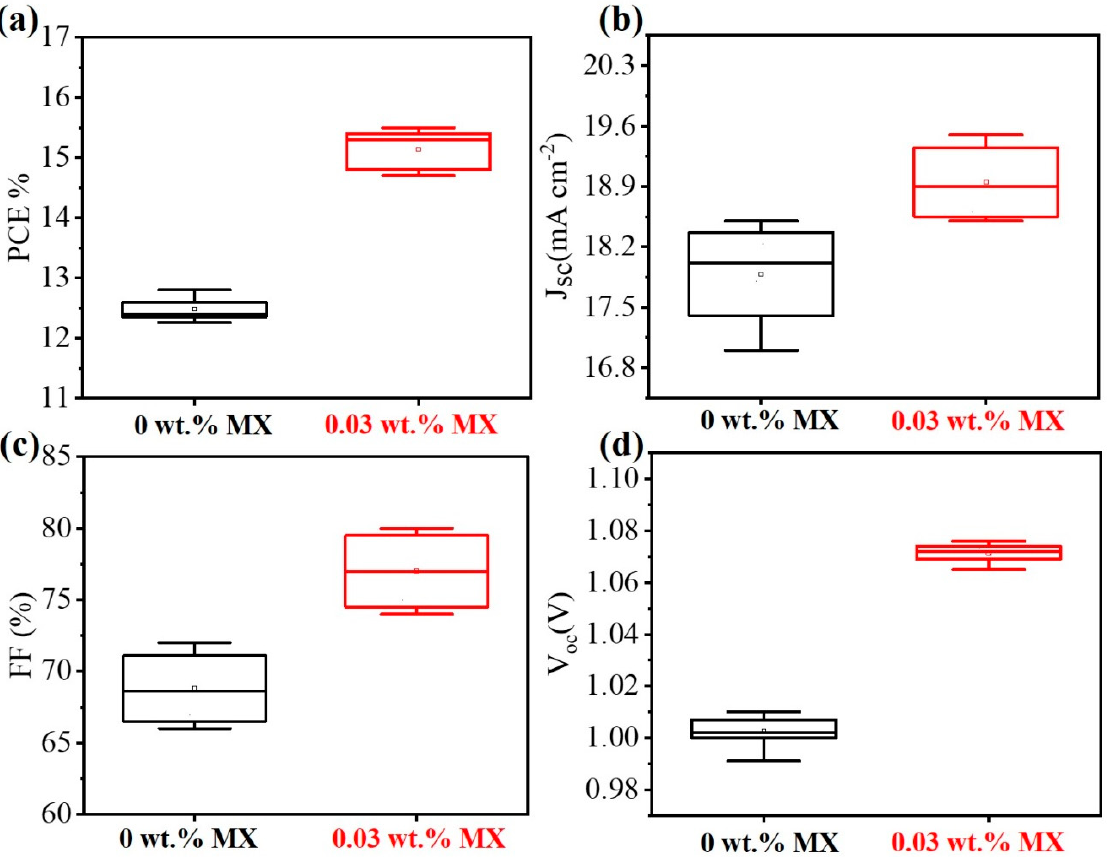
Figure 5. Statistical parameters of PSCs with pure PEDOT:PSS and 0.03 wt.% Ti 3 C 2 T x -doped PE- DOT:PSS (reverse scan): ( a ) power conversion efficiency (PCE); ( b ) short-circuit current density (J sc ); ( c ) fill factor (FF); ( d ) open-circuit voltage (V oc ). Approximately 10 devices for each parameter were statistically analyzed. Table 5. Photovoltaic performance parameters of PSCs employing pristine PEDOT:PSS and differ- ent doping amounts of Ti 3 C 2 T x -doped PEDOT:PSS as HTLs.